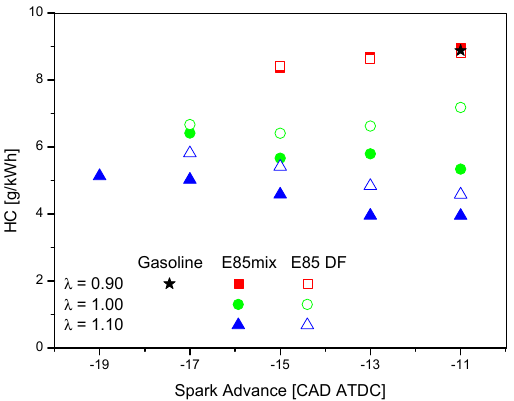
Figure 8. HC emissions against the spark advance at different λ .